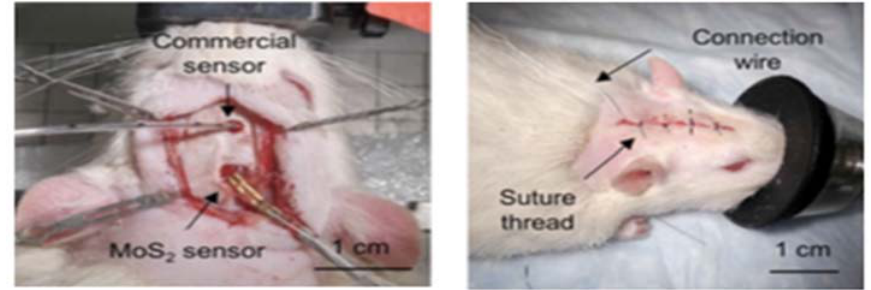
Figure 4. Optical images of a MoS 2 -based bioabsorbable sensor implanted in a rat together with a commercial one before and after suture. Reprinted with permission from ref. [71]. 2019 Springer.